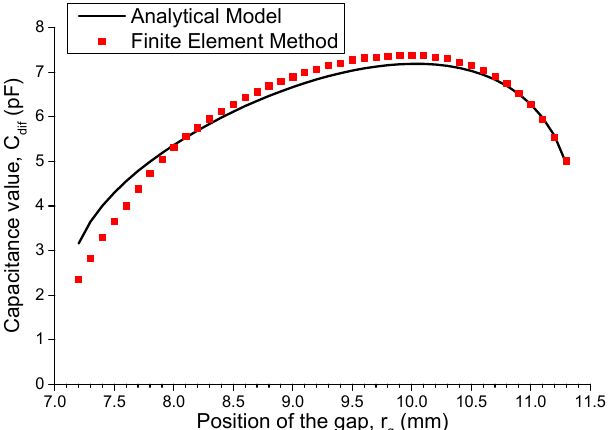
Figure 7. Capacitance values with different gap positions ( r ii = 7 mm, r oo = 11.5 mm, θ 0 = 2 rad, h = 15 mm, and ε = 41.5 × ε 0 ). Sensors 2016 , 16 , 133